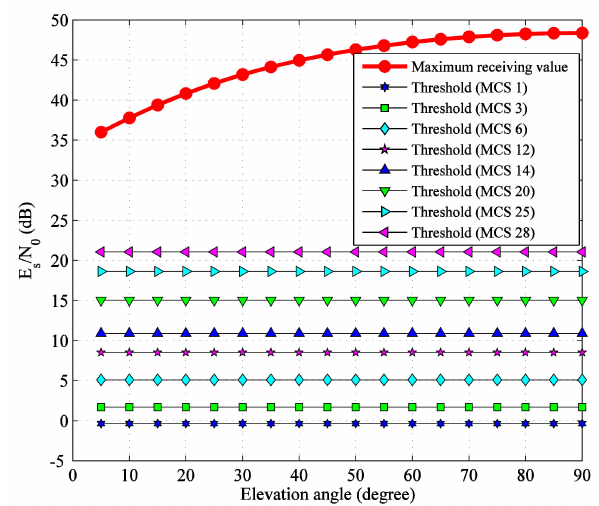
Figure 4. Comparison between receiving value in clear sky and threshold of E S / N 0